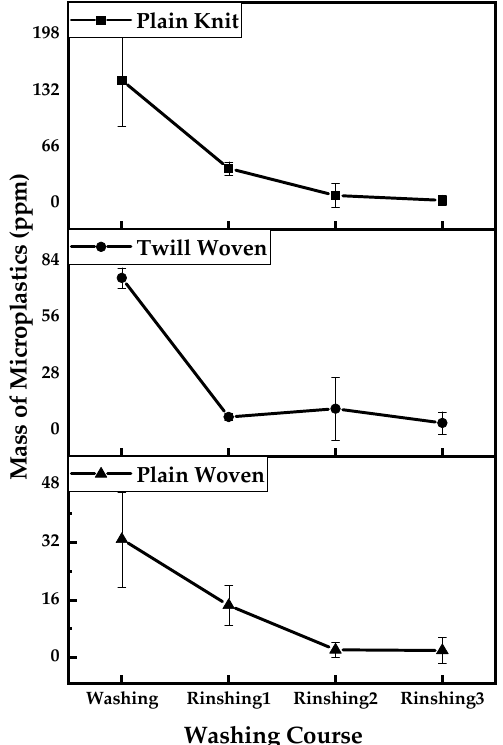
Figure 5. Mass of microplastics released from each washing process.